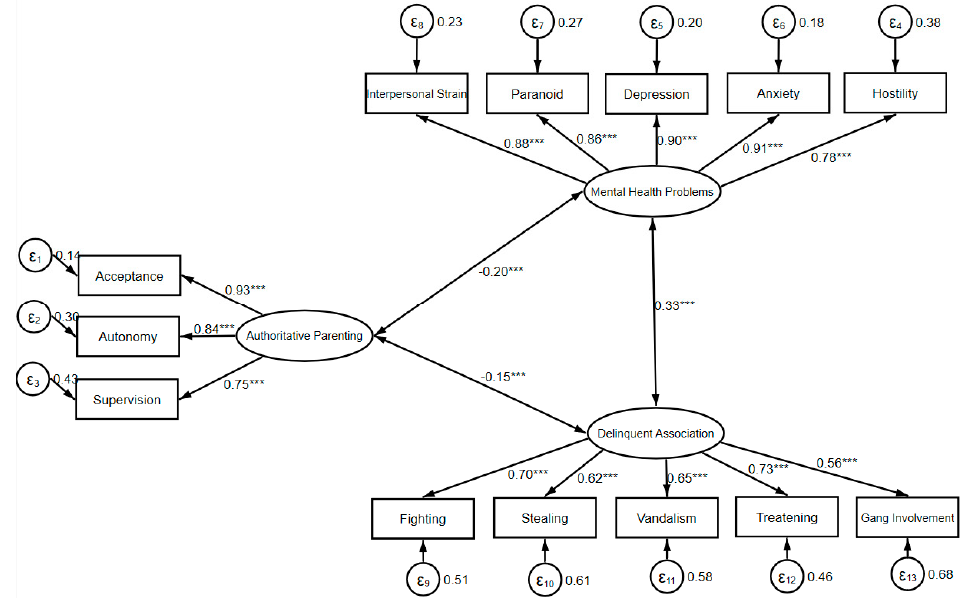
Figure 2. X 2 = 310.888, d.f. = 62, root mean square error of approximation (RMSEA) = 0.062, comparative fit index (CFI) = 0.968, Tucker–Lewis Index (TLI) = 0.960. All of the coefficients